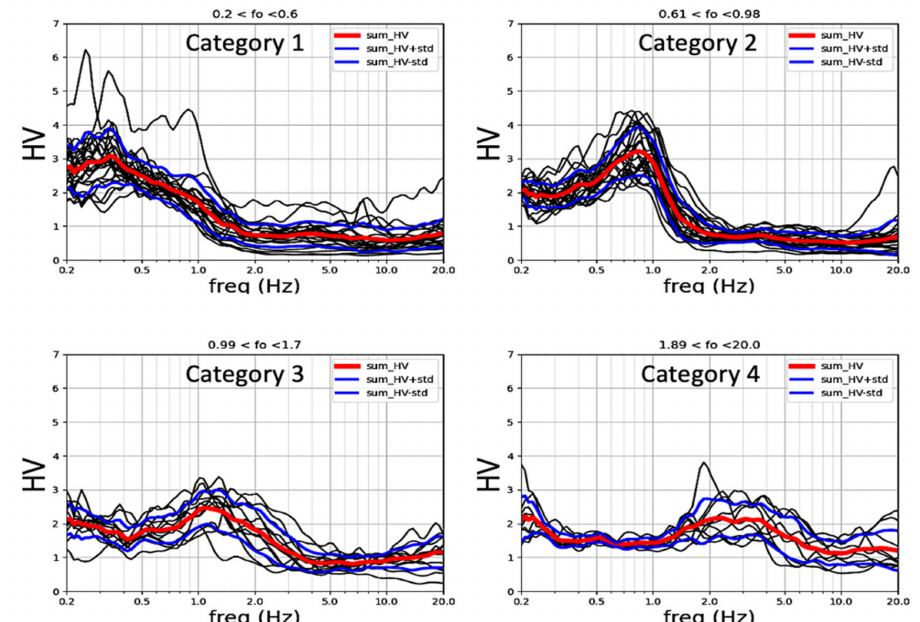
Figure 14. Four categories of HVSRs for the city of Durres (average red line ± one standard deviation blue lines).